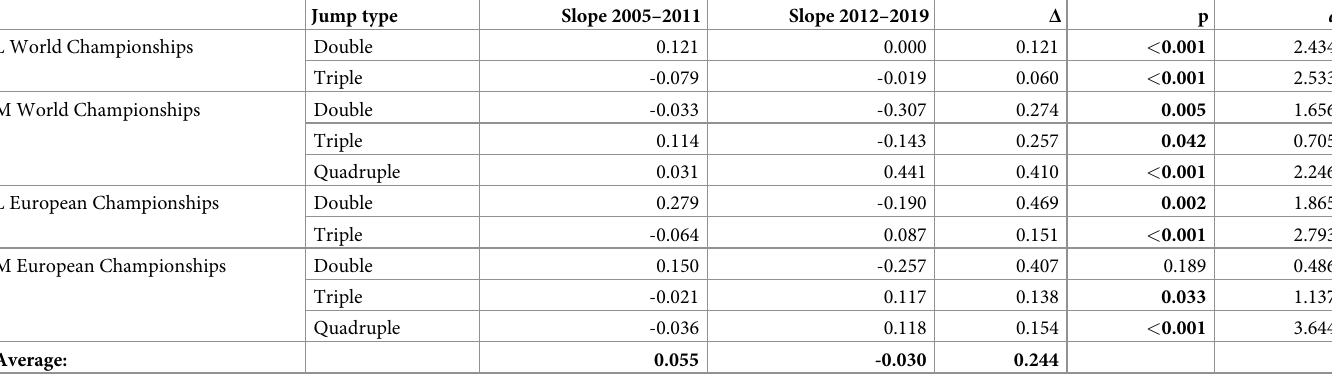
Table 2. Regression slopes (in jumps per year) for each jump type, the difference ( Δ ), p-values (one-sided Student’s T-Test), and effect size ( d